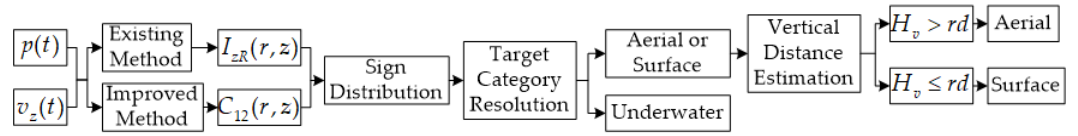
Figure 3. The flow chart of the target category resolution process.